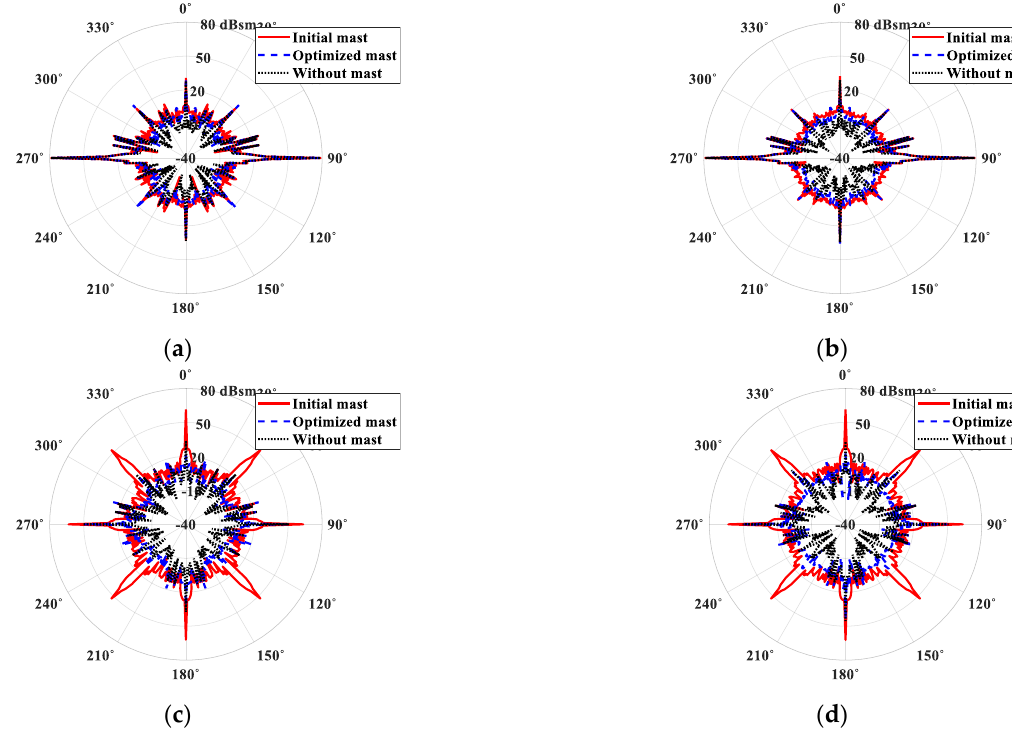
Figure 11. RCS pattern of a naval vessel equipped with the integrated mast in the azimuth plane in the S-band. ( a ) HH polarization at an elevation angle of 0°, ( b ) VV polarization at an elevation angle of 0°, ( c ) HH polarization at an elevation angle of 10°, ( d ) VV polarization at an elevation angle of 10°.